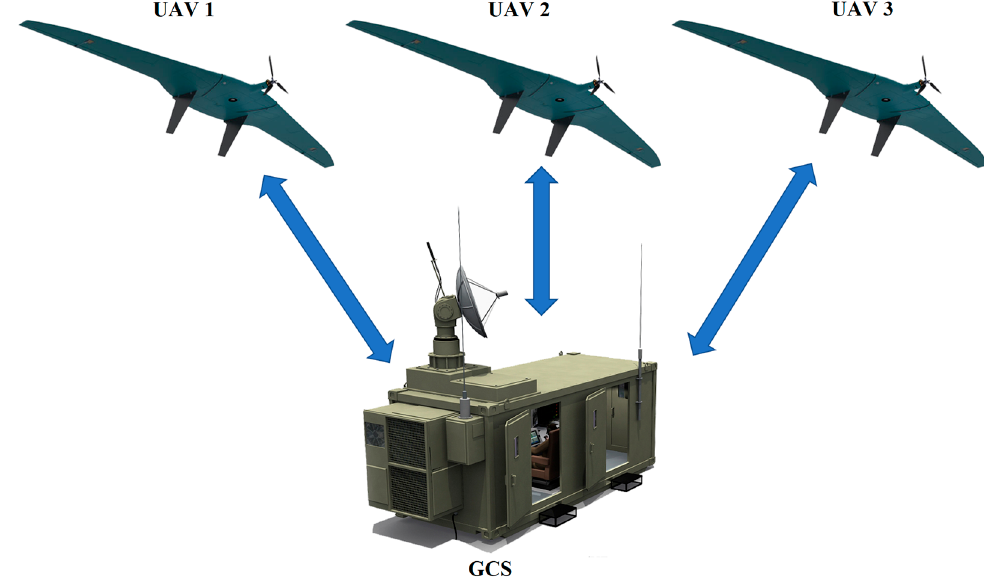
Figure 1. Scheme of the communication option “UAV—GCS”.